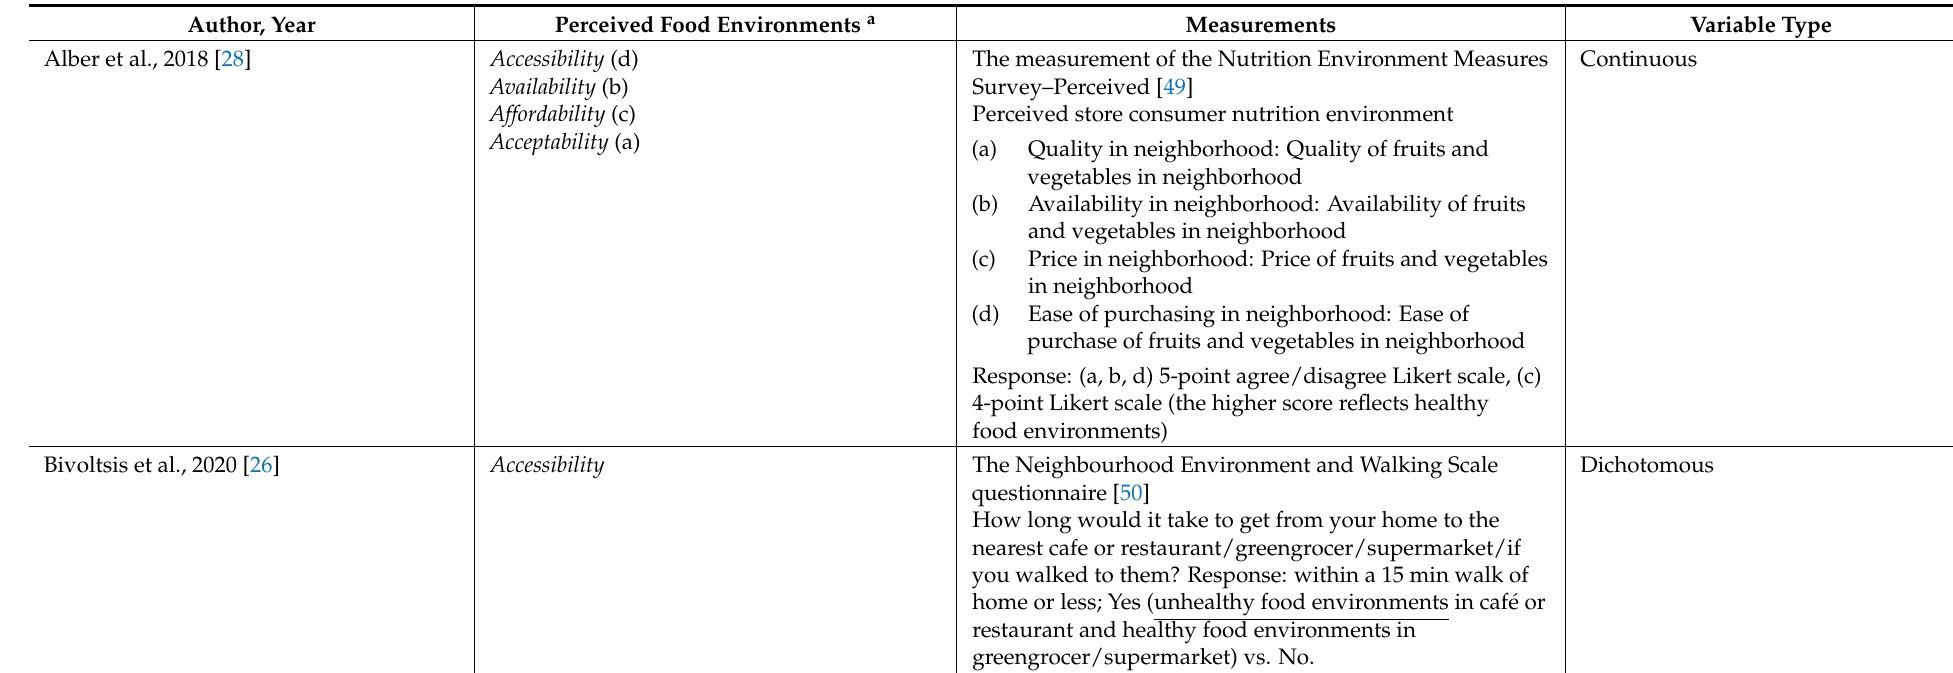
Table 2. The measurement tools for perceived food